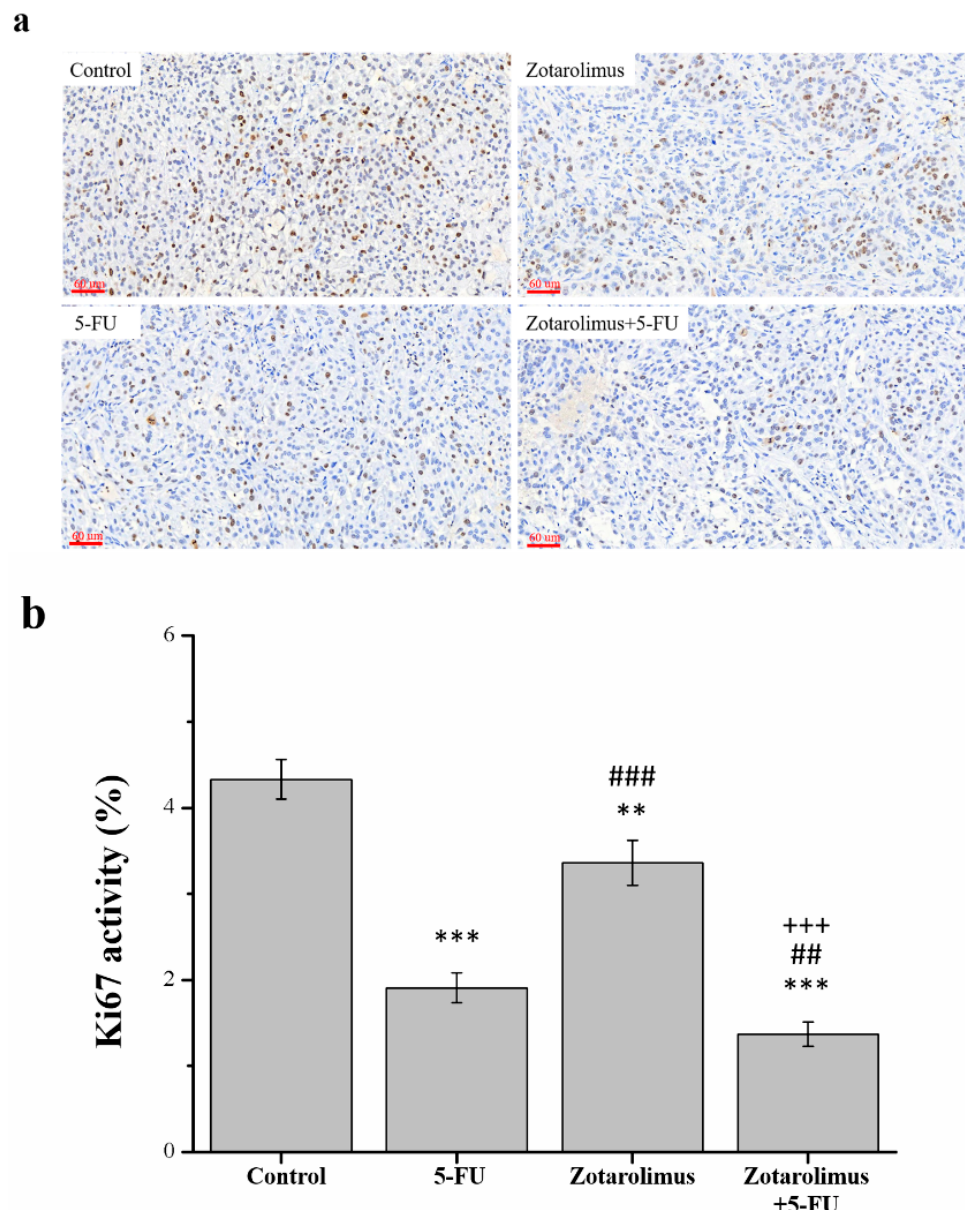
Figure A5. Immunohistochemical expression of ( a ) Ki67 and a comparison of the expression levels of ( b ) Ki67 in the A549 tumor masses from BALB/cByJNarl in control mice and mice given differ- ent treatments, including 5-FU (100 mg/kg/week), zotarolimus (2 mg/kg/day), and zotarolimus (2 mg/kg/day) combined with 5-FU (100 mg/kg/week). All data are presented as mean ± standard deviation, n = 7 per group. ** p < 0.01 and *** p < 0.001 compared with the control group. ## p < 0.01 and ### p < 0.001 compared with the 5-FU-treated group. +++ p < 0.001 compared with the zotaroli- mus-treated group. Scale bars = 60 µm.